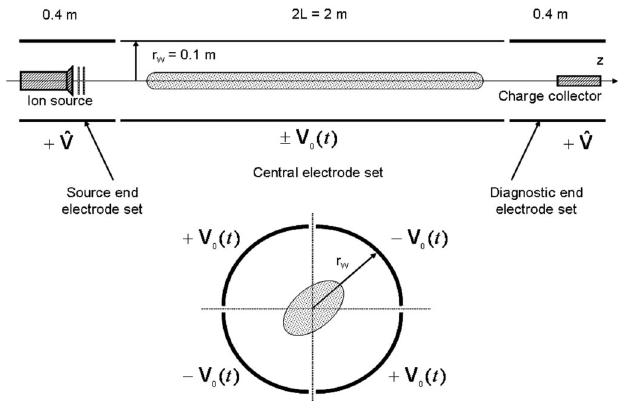
FIG. 1. Schematic of the PTSX device showing the quadrupole electrodes, ion source, and charge